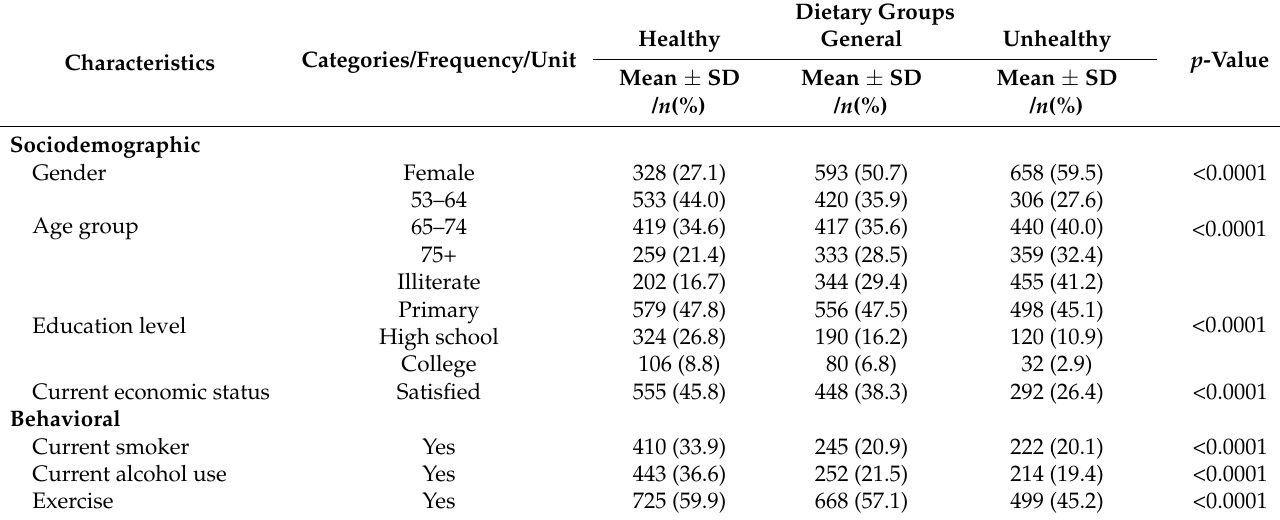
Table 5. Sociodemographic, behavioral, dietary, anthropometric, health status, and food frequency characteristics of three dietary groups at baseline (year